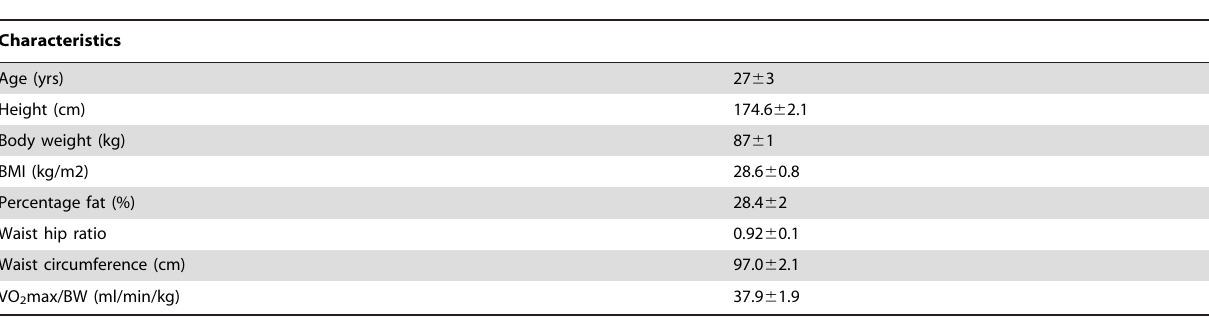
Table 1. Physical characteristics and fitness.